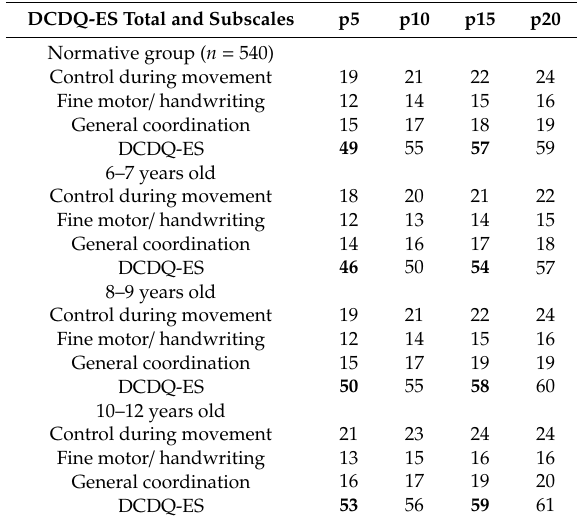
Table 4. Predictive values and Youden’s index of the 5th and the 15th percentiles ( n = 90).